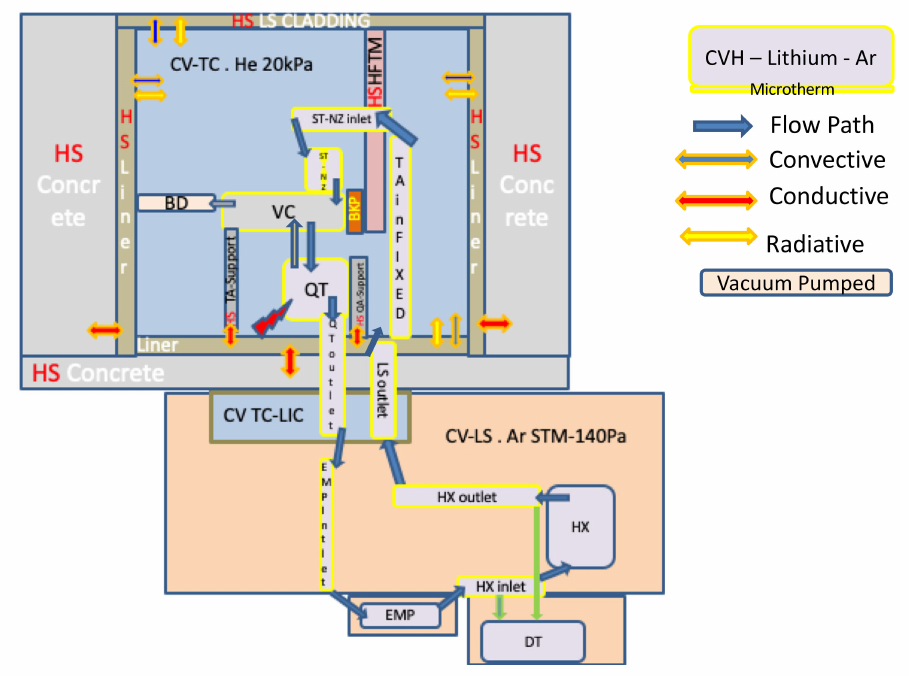
Figure 3. TC-LS Melcor model nodalization.